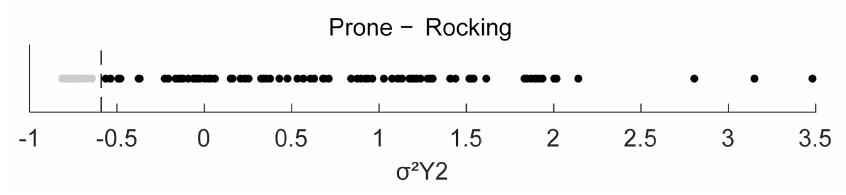
Figure 7. Scatter Plot for Prone-Rocking in one dimension. Dashed line at σ 2 Y2 = − 0.62. The classifier for Rowing performs best when using the split values in Table 6: max( ∆ ϕ 1,2 ) = 0.27, aRMSZ3 = 0.7. Figure 8 shows the corresponding scatter plot. With the specified split values, sensitivity and specificity both are at 82.8%.